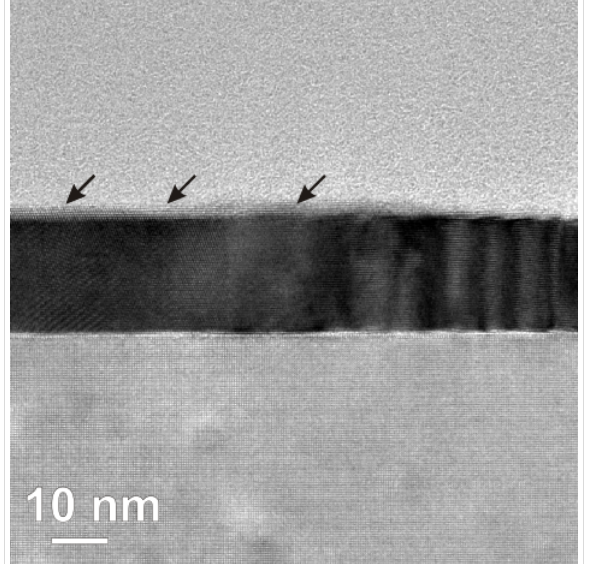
Figure 8: HRTEM image of annealed Co NPs on Pt(100) film after T A = 500 °C for 30 min. The arrows indicate a thin surface layer of Pt-rich Co x Pt 1 − x alloy on top of the Pt (seen by the weaker absorption contrast). Note that this sample has not been covered by any protec- tive